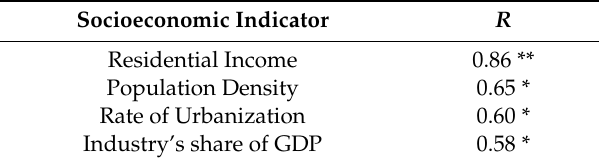
Table 5. Correlation between economic loss by ambient pollutant and socioeconomic